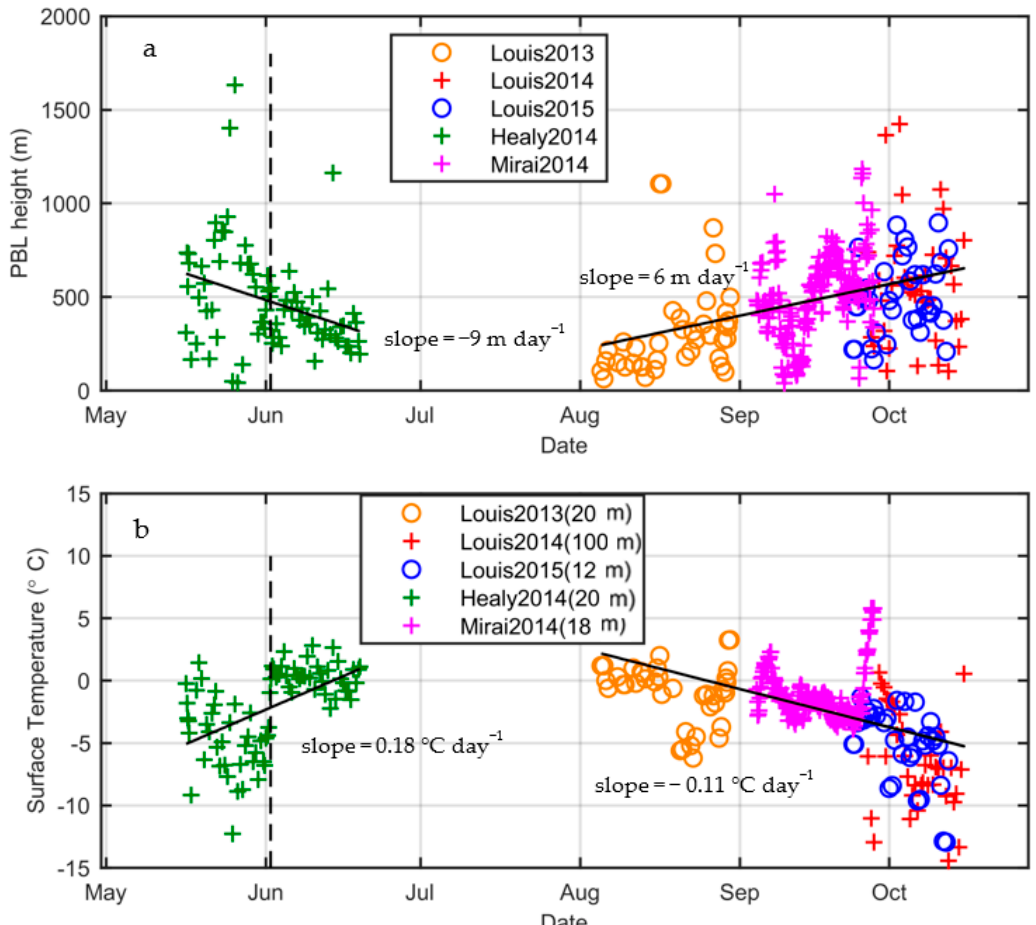
Figure 2. Planetary boundary layer heights ( a ) and the lowest level temperature ( b ) obtained from the radiosonde data of the cruises. The straight lines are the least squares fits for early summer and early autumn, and the slope has been displayed adjacently. The lowest level heights (the first heights from GPS reported) are labeled correspondingly. The vertical dashed lines divide Healy 2014 into a cold and warm period. Table 1. Mean PBLH (m) from ERA5 and each cruise.